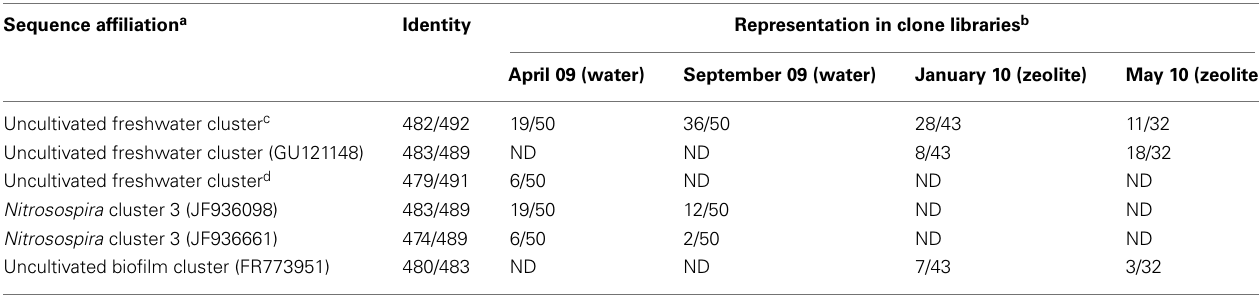
Table 4 | DominantAOB groups in native water samples and attached to zeolite particles as determined by clone libraries and sequencing of PCR-amplified amoA genes.